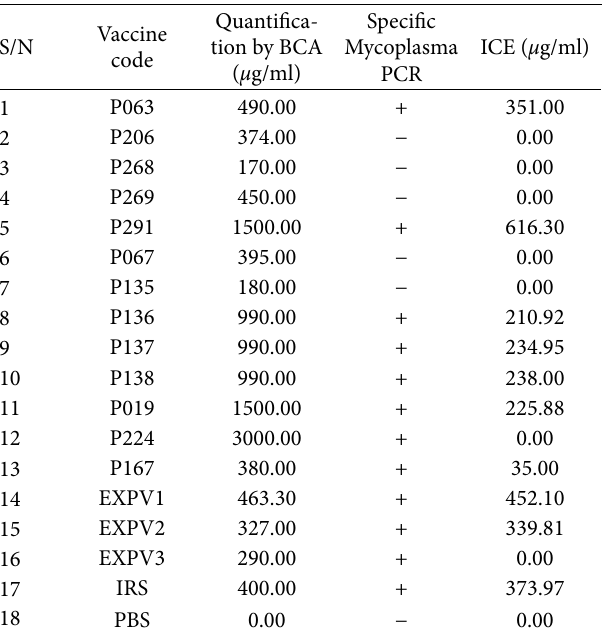
Table 3: Detection of CCPP using BCA method quantification, PCR, and ICE tests.